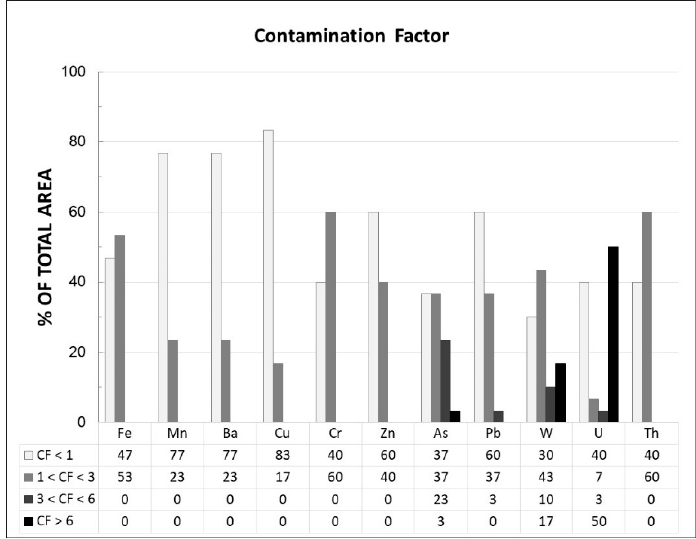
Figure 3. Percentage of contamination factor classes in the Canto Lagar area.